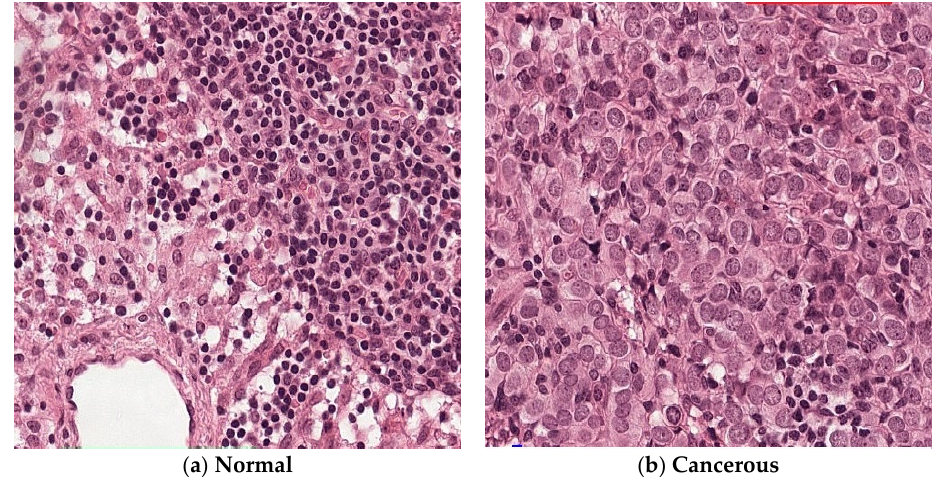
Figure 3. Samples of the PatchCamelyon dataset. ( a ) A normal sample. ( b ) A cancerous sample.